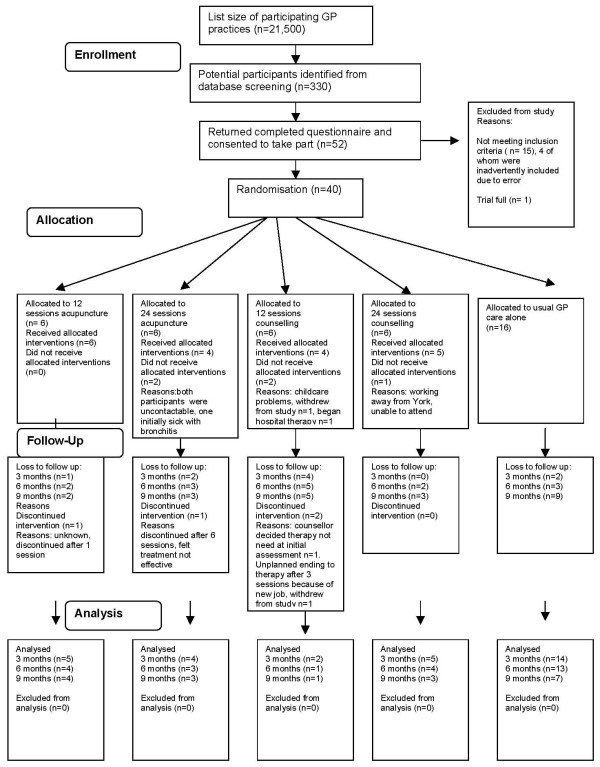
Study flow diagram.